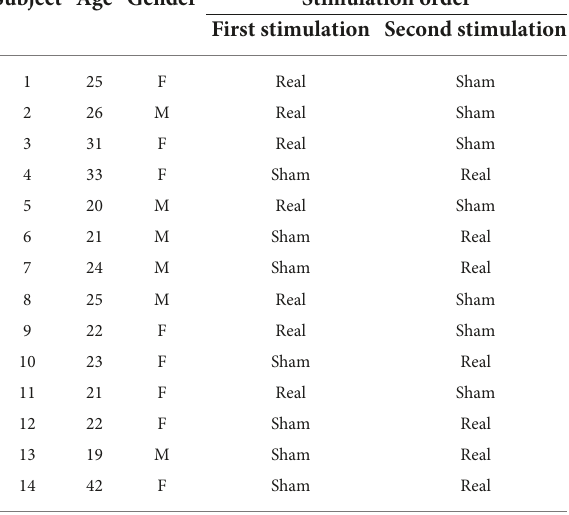
TABLE 1 Subjects’ demographic information and stimulation